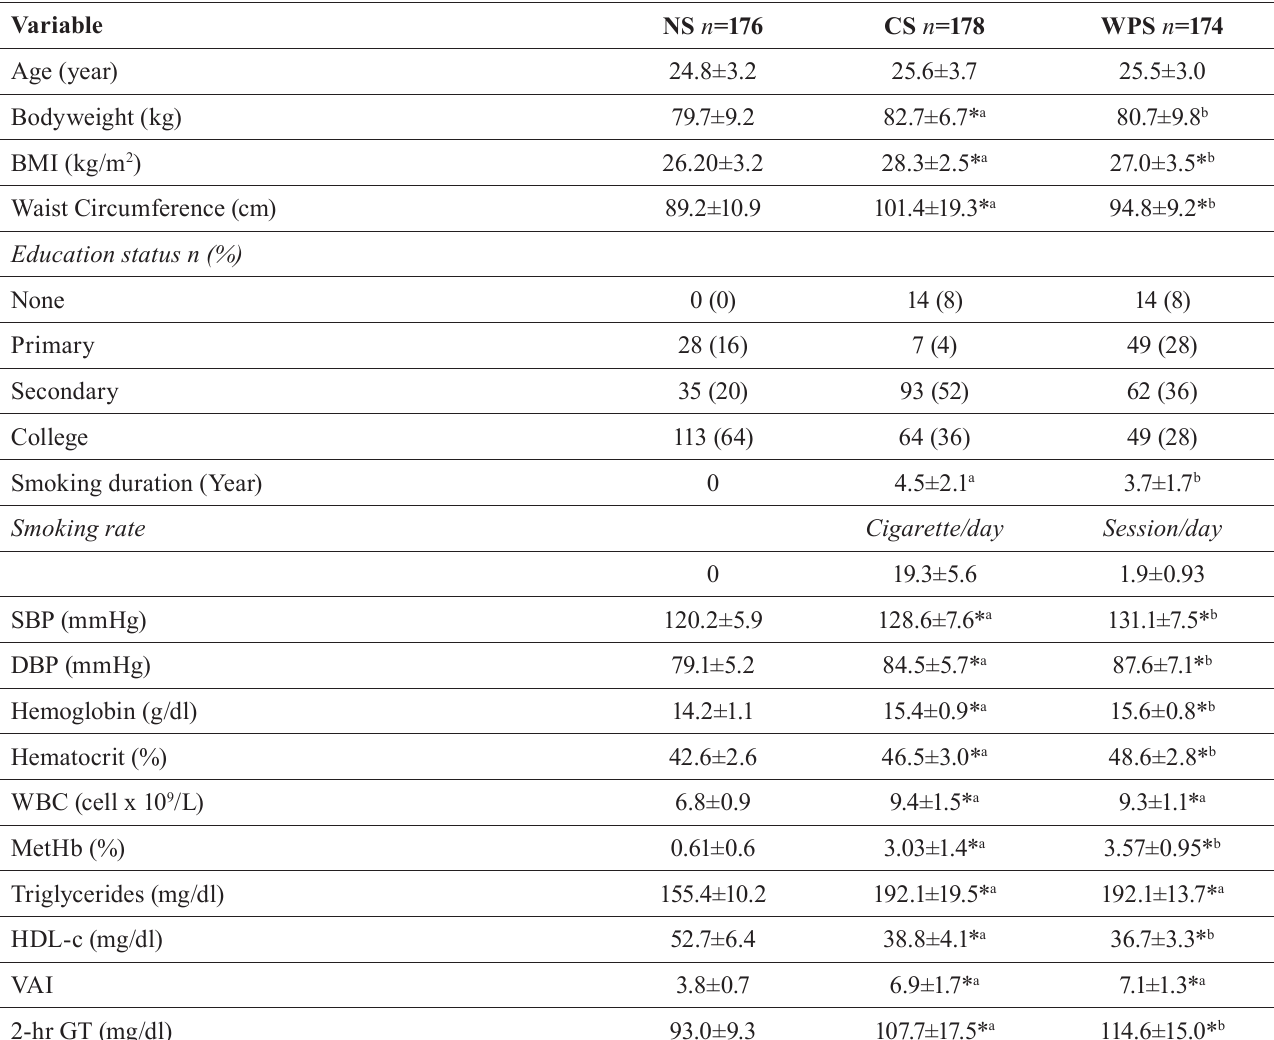
TABLE I - D emographic, anthropometric and metabolic characteristics of the surveyed subjects Variable